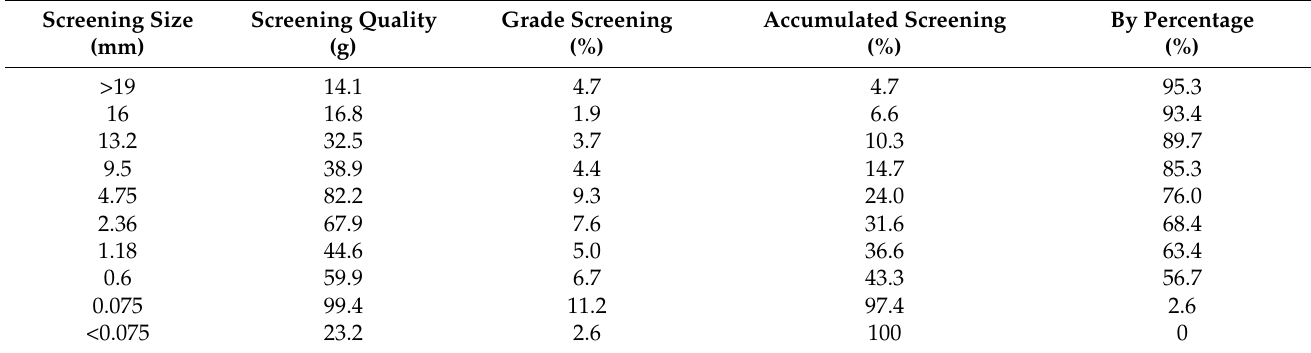
Table 3. Screening results of natural